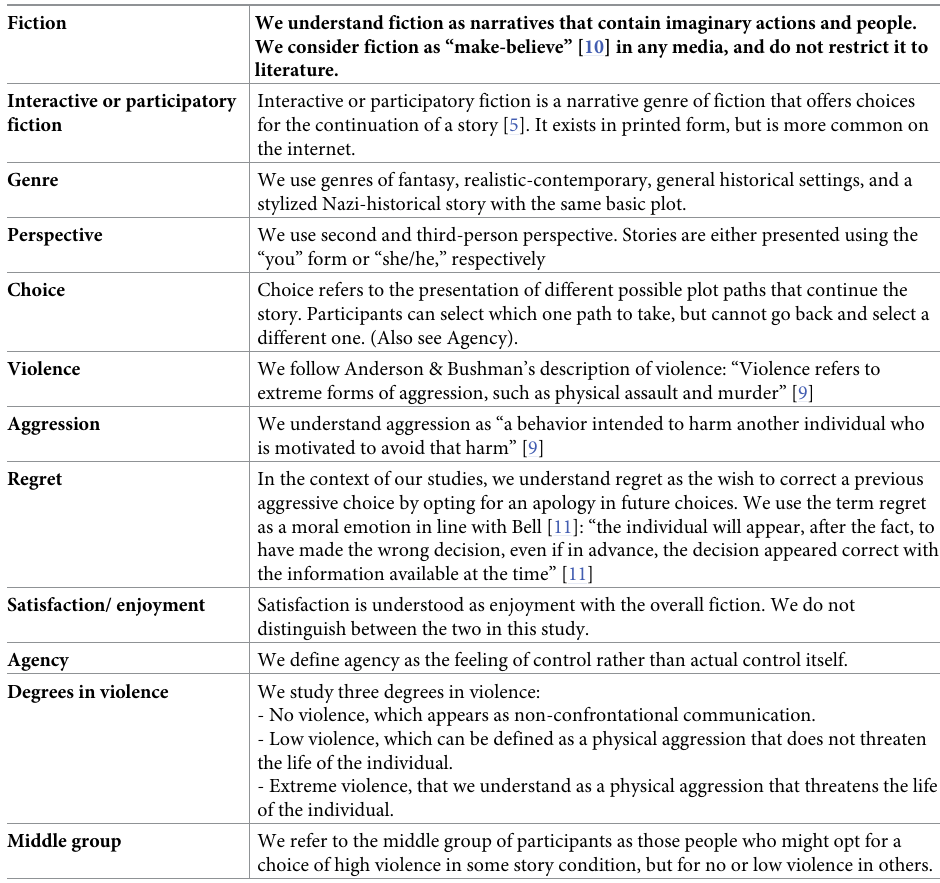
Table 1. Key terms of our